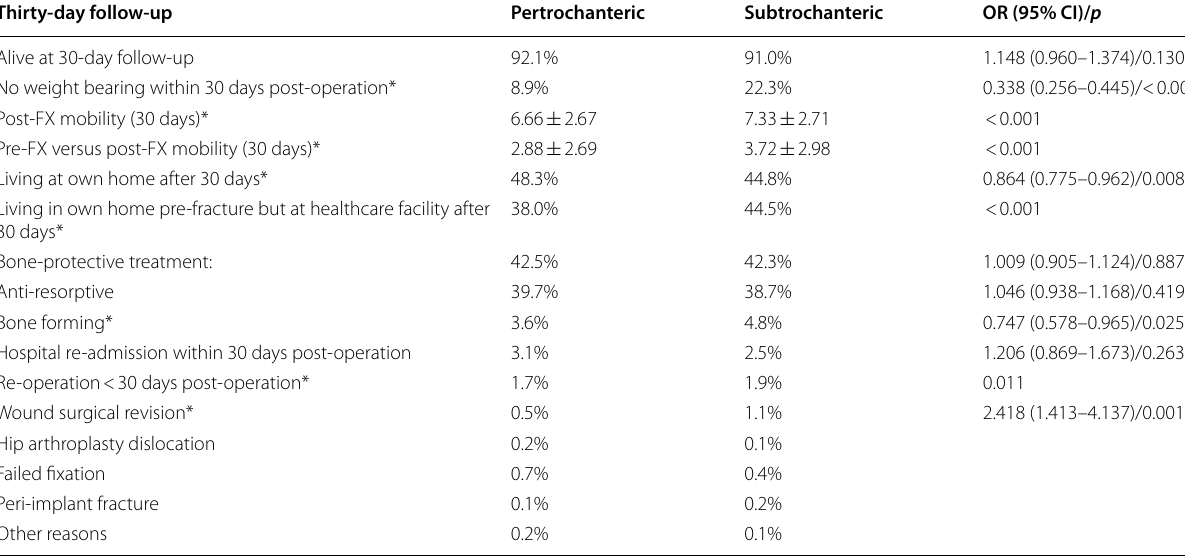
standard deviation and percentage ±